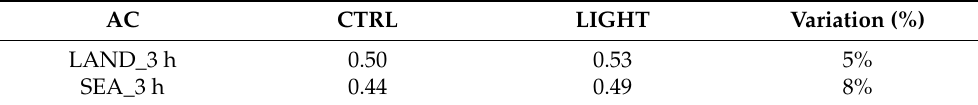
Table 2. Average of the anomaly correlation (AC) for the whole period for the 3 h precipitation, for the CTRL forecast, the LIGHT forecast, and the improvement of LIGHT compared to CTRL in percentage